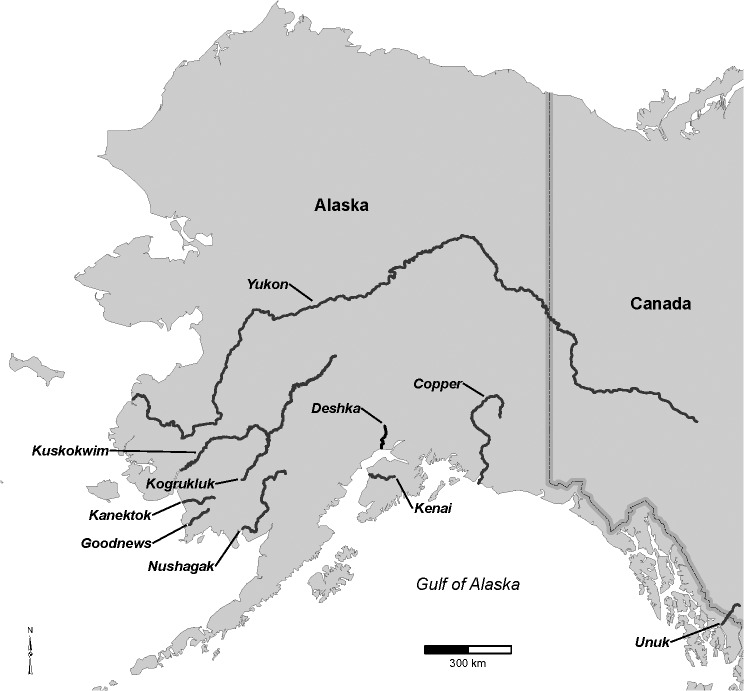
Map of Alaska with locations of Chinook salmon populations discussed in this study.